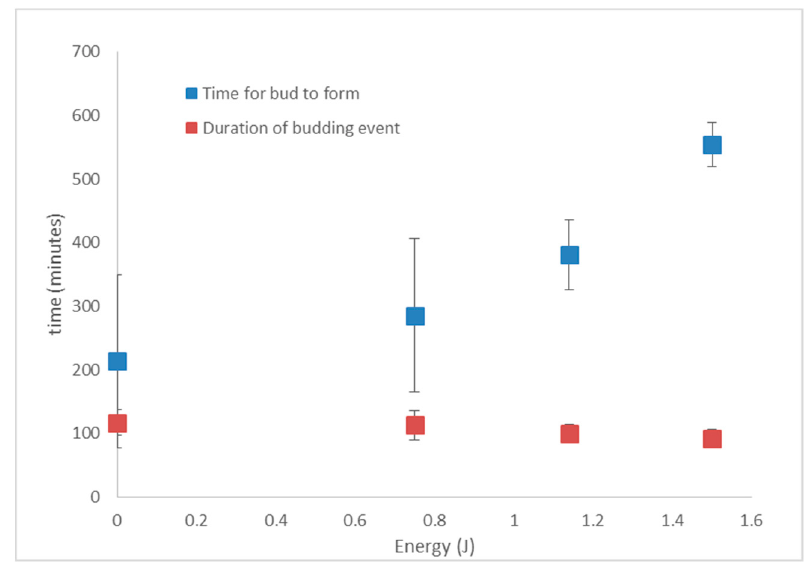
Figure 10. The dependence of time for bud to appear on tweezed cell, and the duration of the budding event on the laser